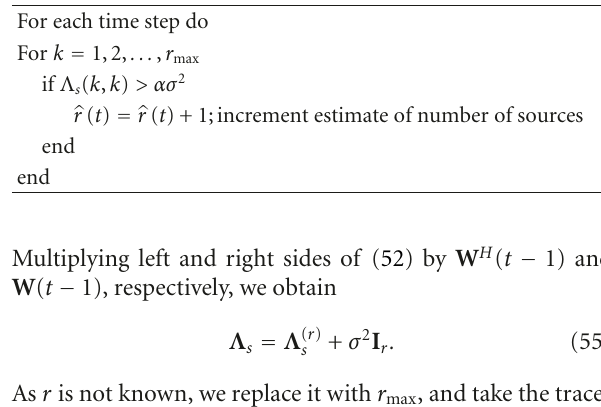
Table 5: Signal subspace rank estimation.